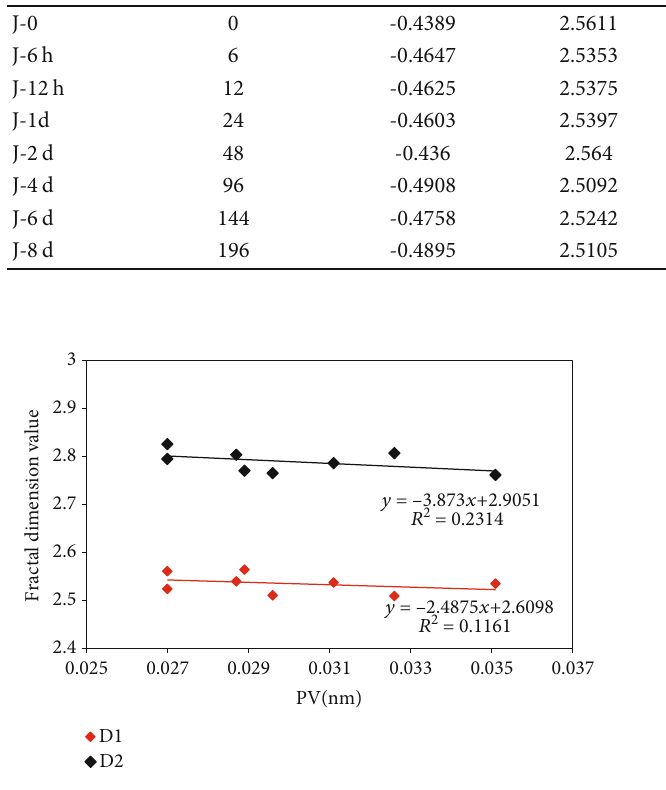
Figure 7: Relationship between fractal dimensions and PV.